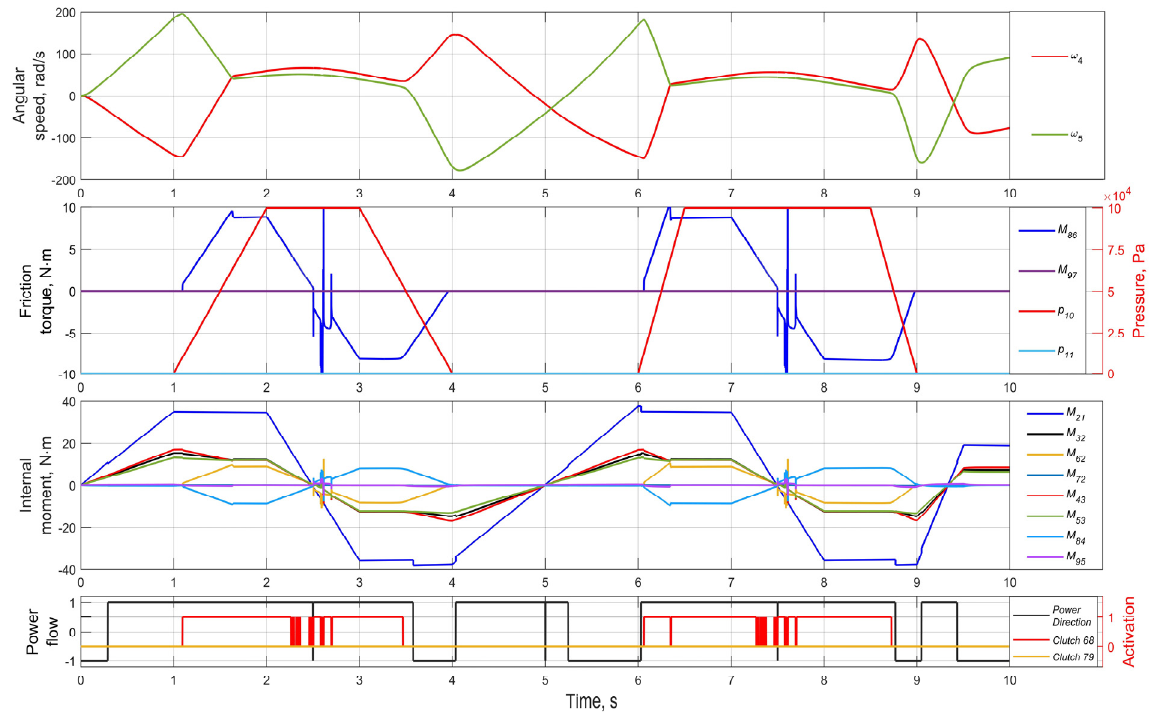
Figure 8. Modeling the mode of activating clutch 6–8.